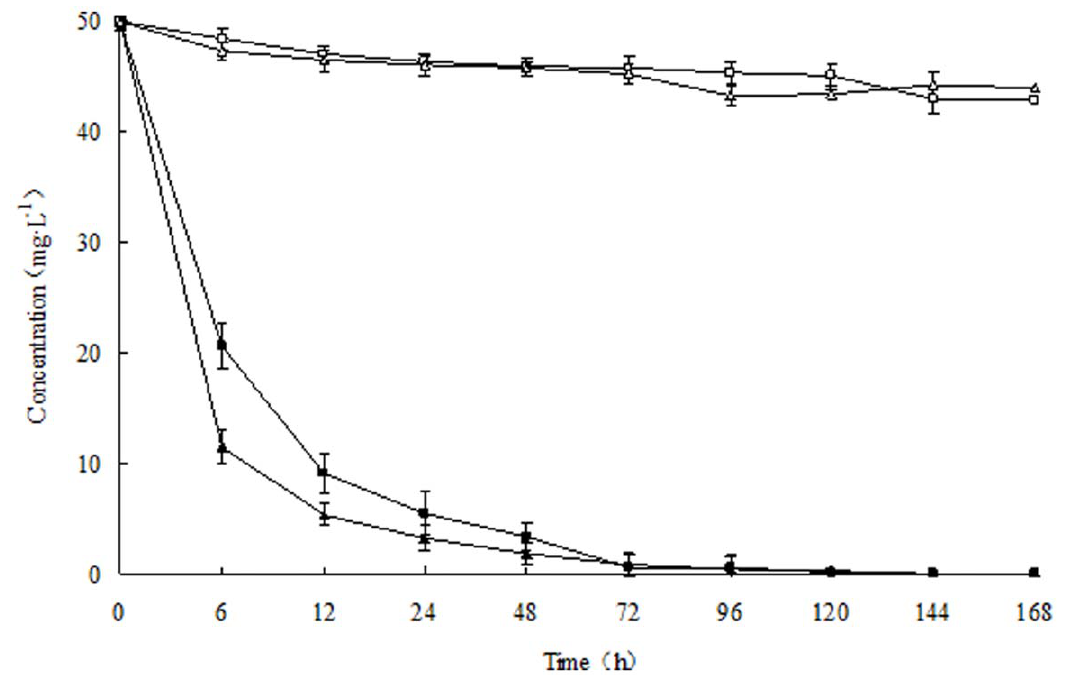
Figure 6. Degradation kinetics of chlorpyrifos and 3,5,6-trichloro-2-pyridinol (TCP) during biodegradation studies. % , non- inoculated control (chlorpyrifos); g , non-inoculated control (TCP); & , introduction with strain Hu-01 (chlorpyrifos); m , introduction with strain Hu- 01(TCP). Error bars represent the standard deviation of three replicates.